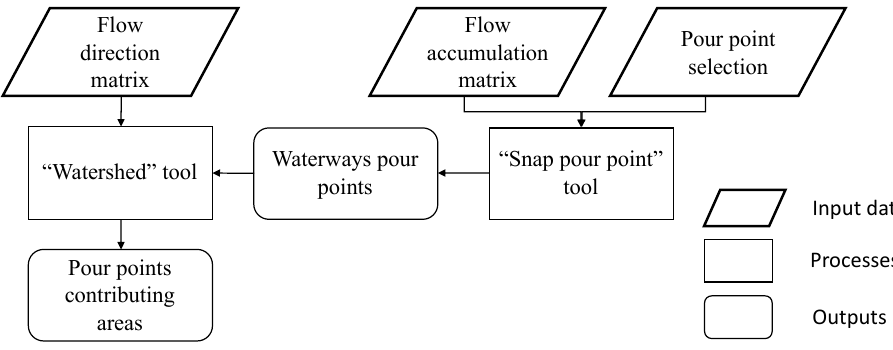
Figure 13. Generating the pour point contributing areas with the “Watershed” tool.